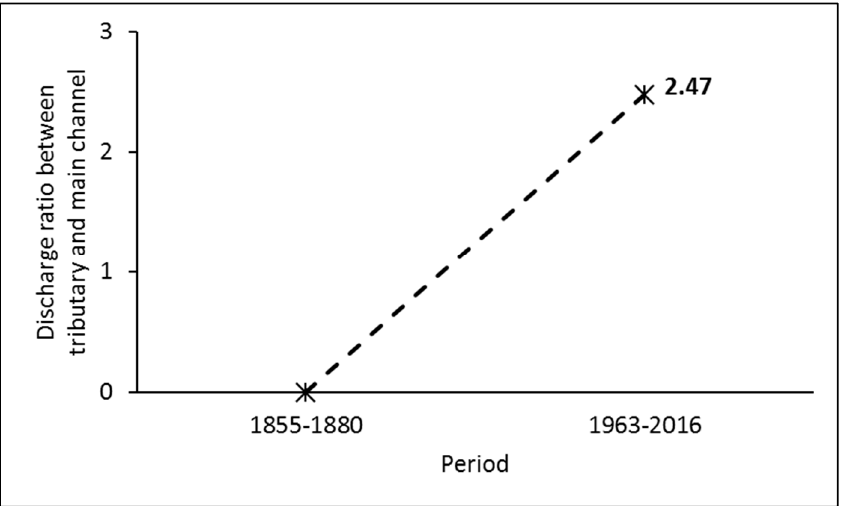
Figure 11. Discharge ratio between diversion Outflow Channel (tributary) and the Red River (main channel) of the Outflow Channel / Red River confluence during the period of 1855–2016. The increase was very likely linear because the discharge ratio increased linearly after 1930 showing in Figure 12.